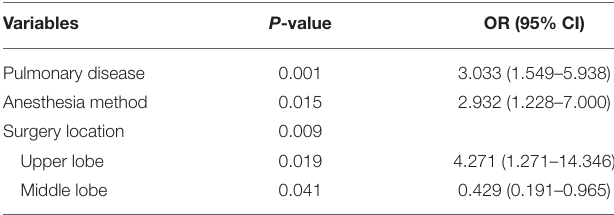
TABLE 3 | Risk factors of postoperative clinical